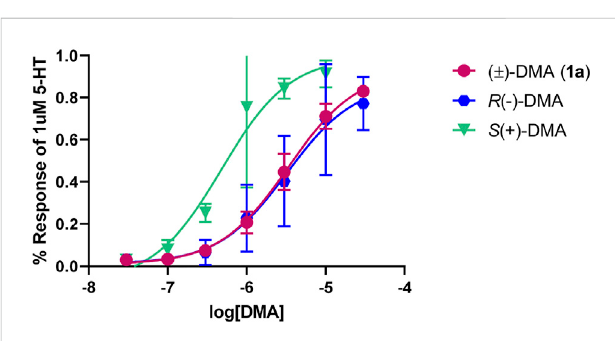
FIGURE 3 Concentration-response curves for 2,5-DMA ( 1a ) and its optical isomers at the 5-HT 2B receptor, normalized to 1 µM of the endogenous ligand (5-HT)